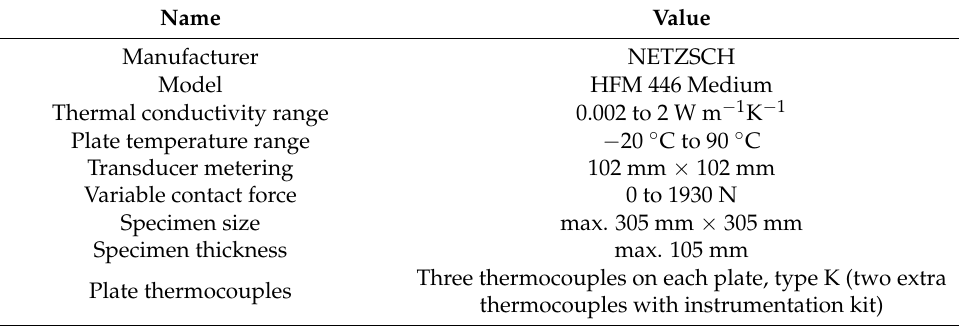
Table 1. NETZSCH HFM 446 Lambda Medium